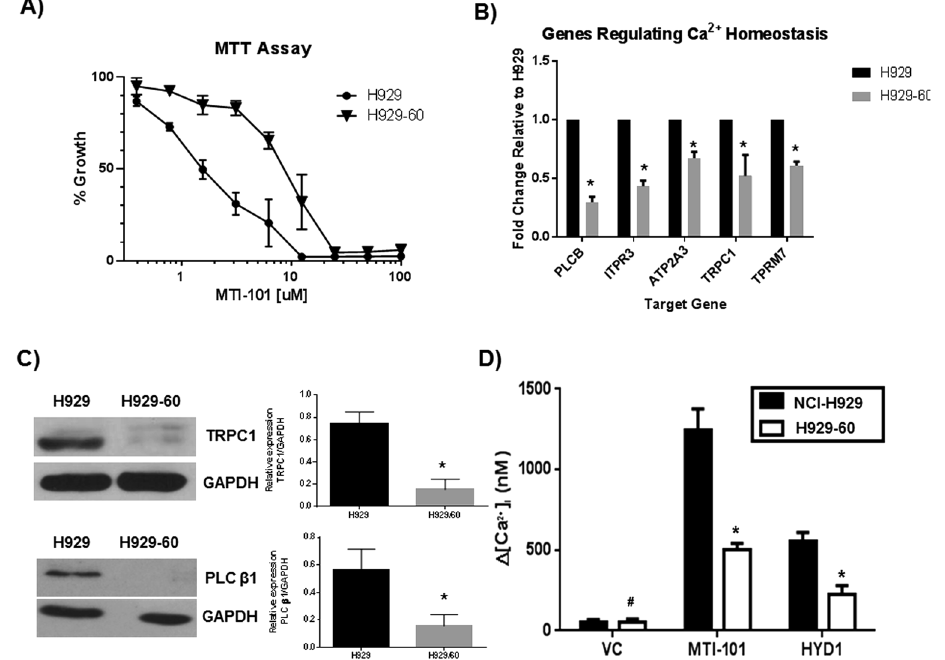
Figure 1. Selection for HYD1 resistance in NCI-H929 MM cells correlates with changes in Ca 2 + signaling pathways. ( A ) Effect of MTI-101 on parentral (NCI-H929) and acquired drug resistant H929-60 cells. The H929-60 cells were developed by continuous exposure to the first generation linear peptide referred to as HYD-1. The H929-60 cell line is cross resistant to MTI-101 induced growth arrest. IC50 values of MTI-101 were determined using the MTT cell viability assay. Each value in the curve is the average of 3 independent